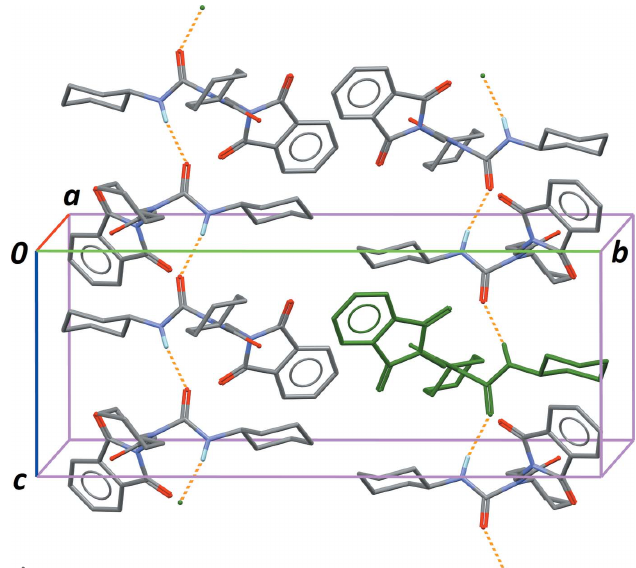
Figure 2 Part of the crystal structure, showing the one-dimensional supramolecular network formed by N—H (cid:3)(cid:3)(cid:3) O hydrogen bonds (dashed orange bonds, see Table 1). The green molecule corresponds to the asymmetric unit. All H atoms were omitted, except H14, which is involved in hydrogen bonds.